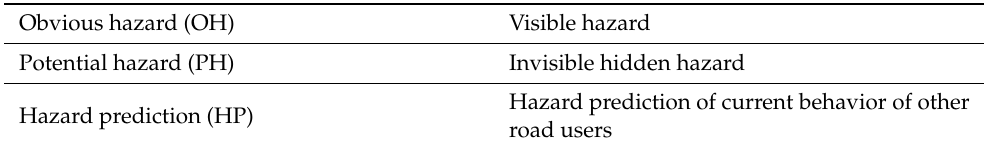
Table 1. The definition of hazard types in this